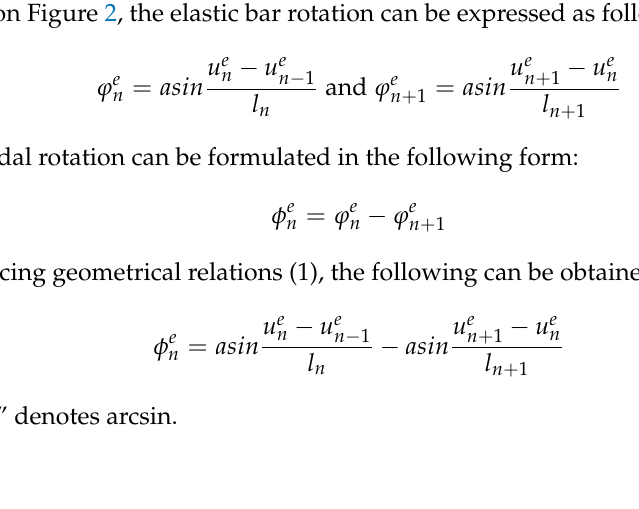
Figure 2. Geometrical relation in the model of the structure.